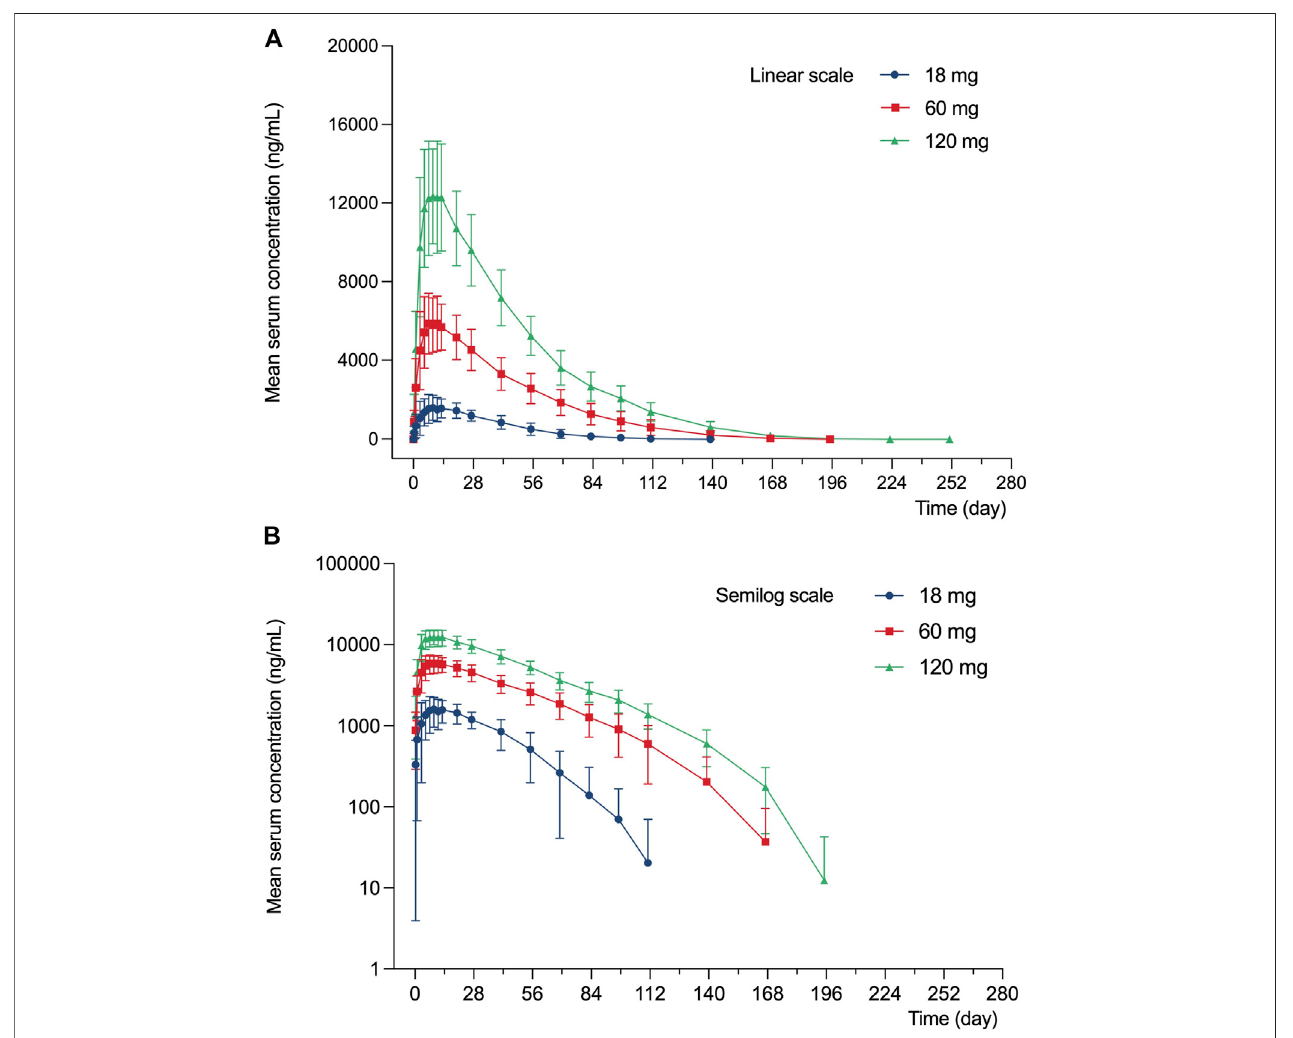
FIGURE 2 | Mean (SD) serum concentration pro fi le of LY060006 (A) Linear scale. (B) Semilogarithmic scale.